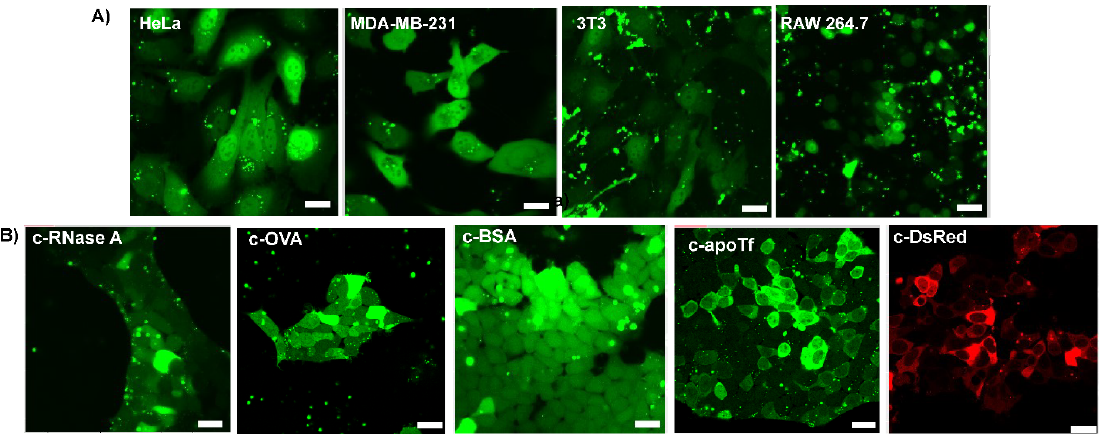
Figure 3. Representative confocal images of delivery with different anhydride-modified proteins after 24 h incubation. The assemblies were delivered at a Guan/Protein ratio of 150 (scale bar: 25 µ m). ( A ) Cytosolic delivery of c − EGFP to different cell lines. ( B ) Cytosolic delivery of different proteins to HEK-293T cells .